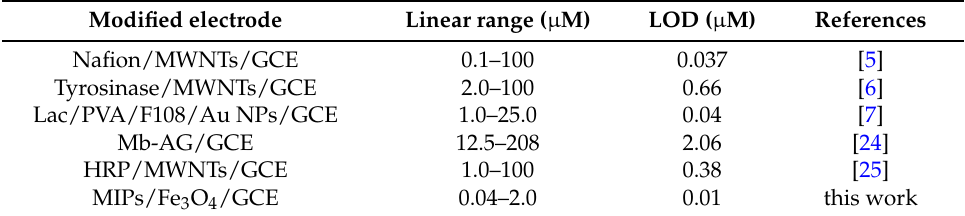
Figure 5. Square wave voltammetry (SWVs) of MIPs/Fe 3 O 4 /GCE in solution containing different concentrations of 2,4-DCP, from a – g : 0, 0.04, 0.16, 0.32, 0.56, 1.2, 2.0 µ M. Inset: plot of peak current versus 2,4-DCP concentration. Table 1. The determination performance comparison with other electrochemical methods.